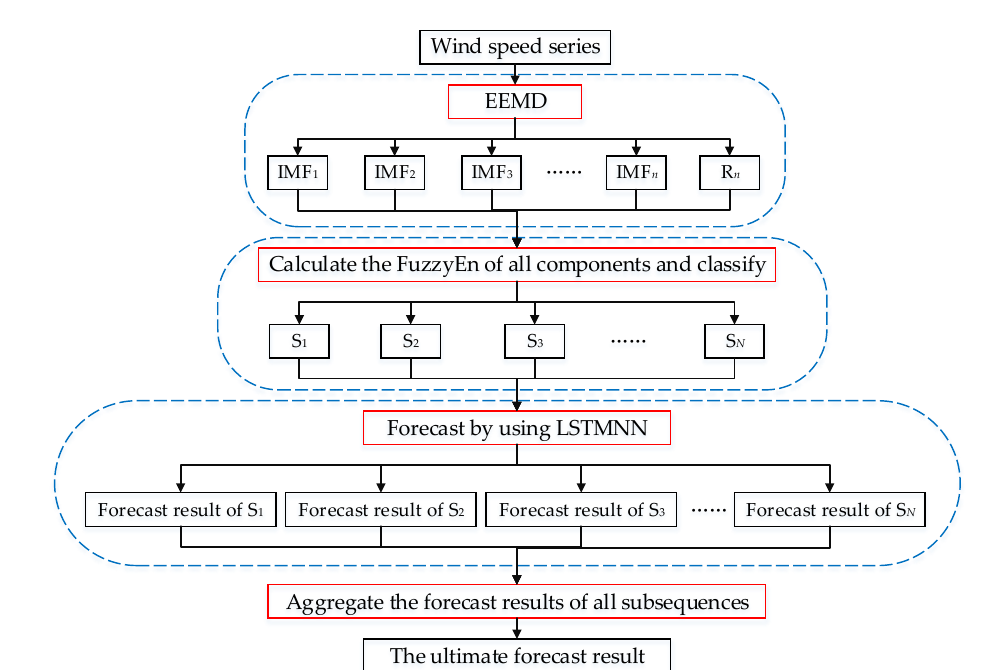
Figure 3. The flowchart of the EEMD-FuzzyEn-LSTMNN model.